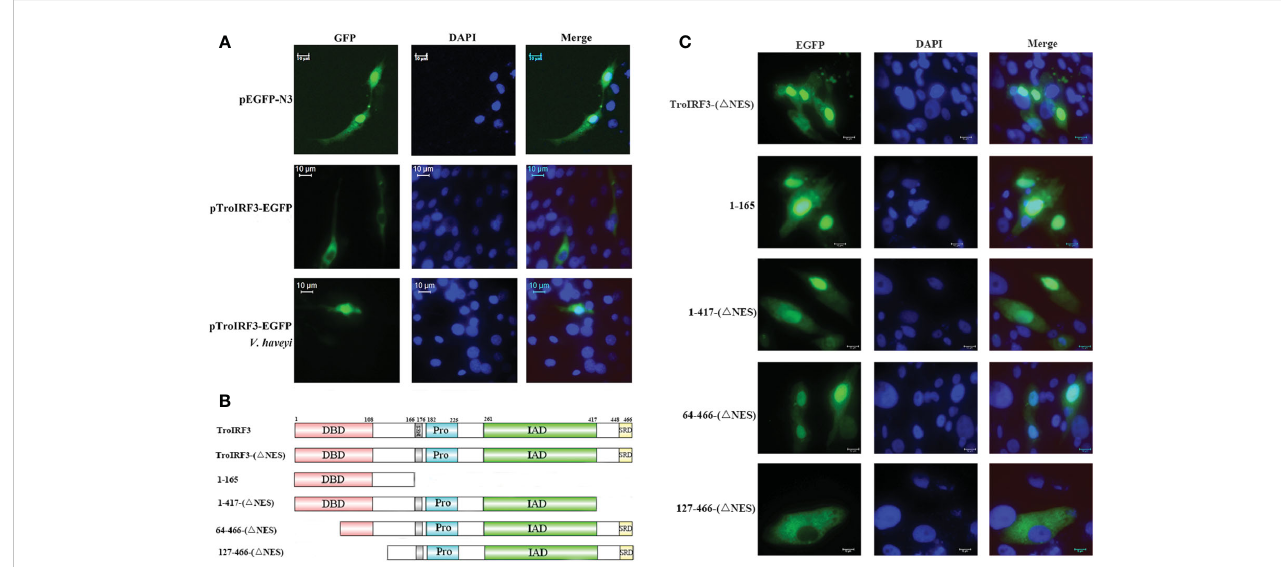
FIGURE 4 Mapping of the TroIRF3 NLS domain. (A) GPS cells were transfected with pEGFP-N3 or pTroIRF3-N3 for 48 h, and the cell transfected with pTroIRF3-N3 were incubated with PBS or V. haveyi for six hours, followed by inverted fl uorescence microscopy imaging. DAPI was used to stain the nuclei of cells. (B) Schematic presentation of TroIRF3-GFP truncation mutants. (C) GPS cells were transfected with TroIRF3-GFP truncation mutant plasmids for 48 h before examination by an inverted fl uorescence